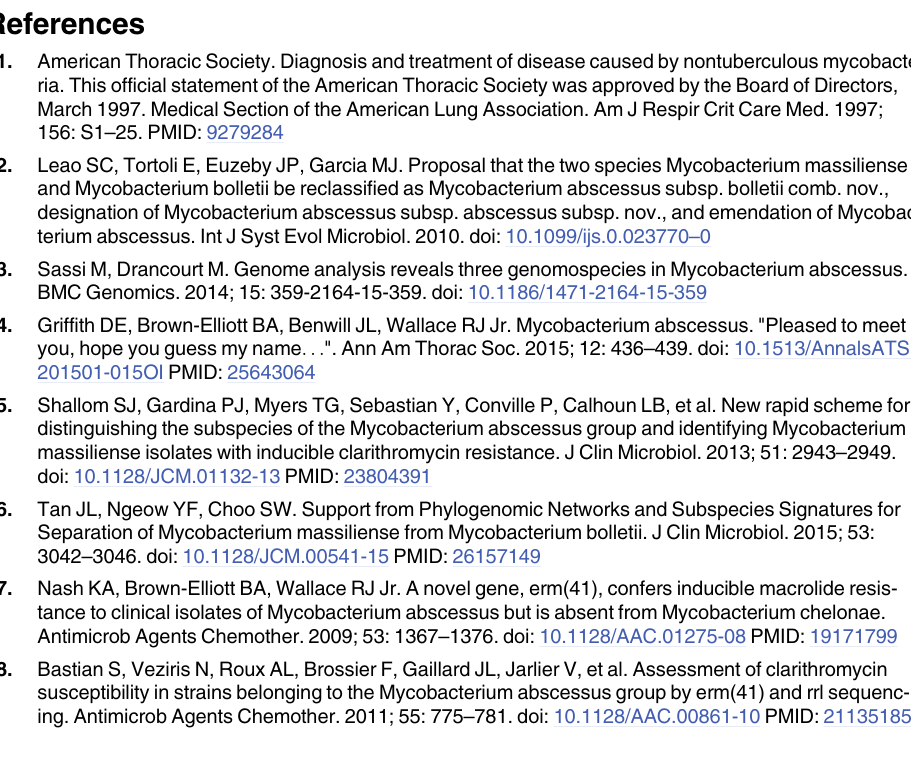
S1 Table. Line list of subspeciation, days to detection of inducible macrolide resistance, erm (41) sequence and Sequevar data for study